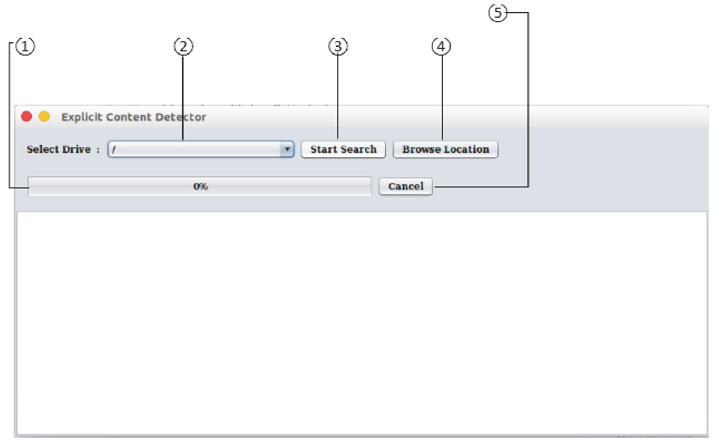
Figure 7: Front end of ECD software.